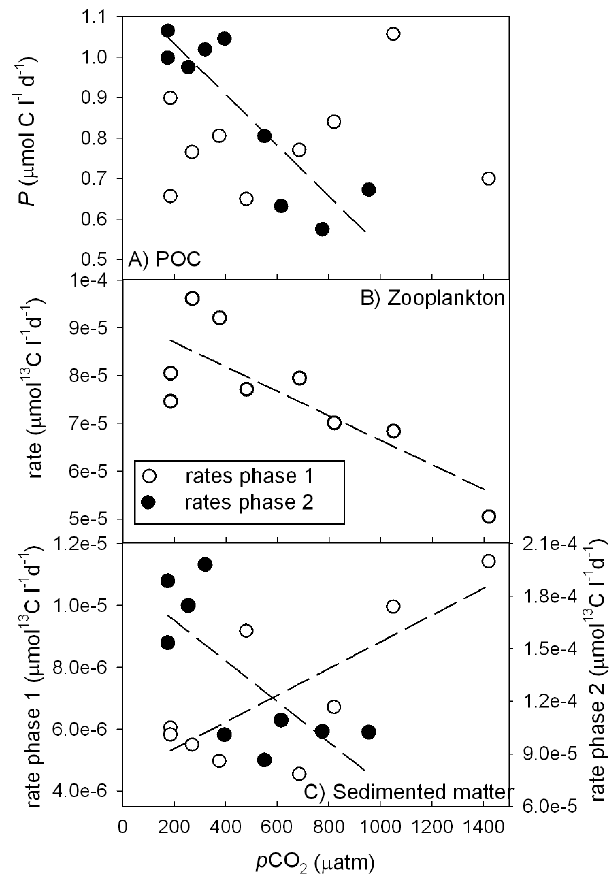
Fig. 4. (A) POC production (µmolCL − 1 d − 1 ) before (phase 1) and after nutrient addition (phase 2); (B) 13 C increase in zooplankton (µmol 13 CL − 1 d − 1 ) from t 0 − 18 ; (C) 13 C increase in cumulative sedimented organic matter (µmol 13 CL − 1 d − 1 ) before (phase 1) and after nutrient addition (phase 2) as a function of average p CO 2 levels of the corresponding